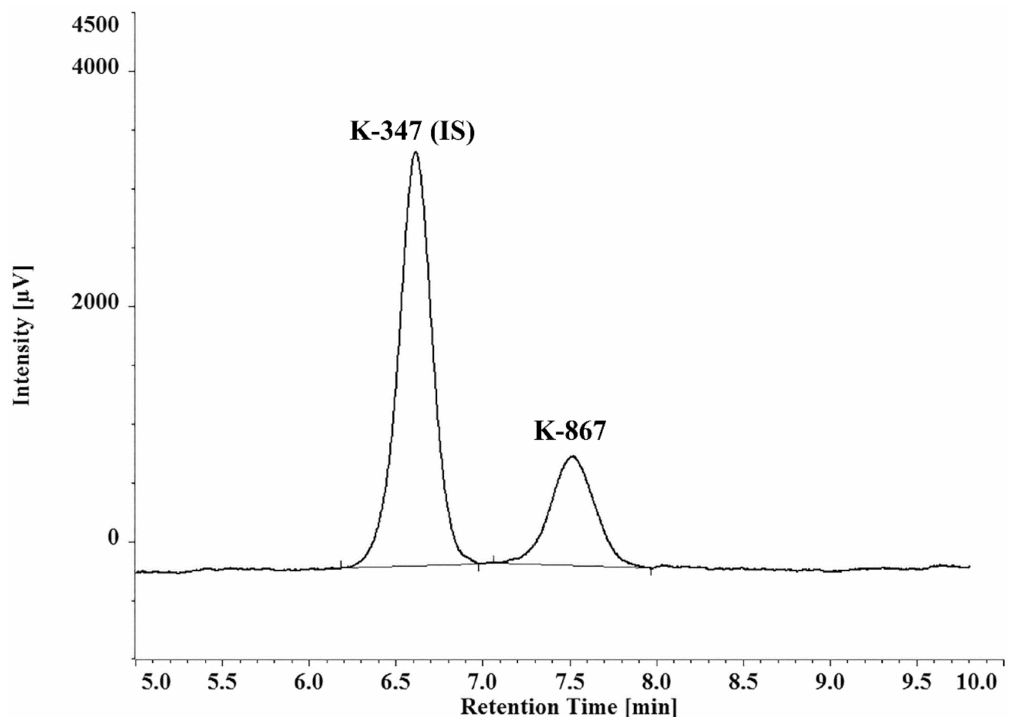
Figure 2. Chromatogram of a representative separation of K-347 (IS) and K-867.